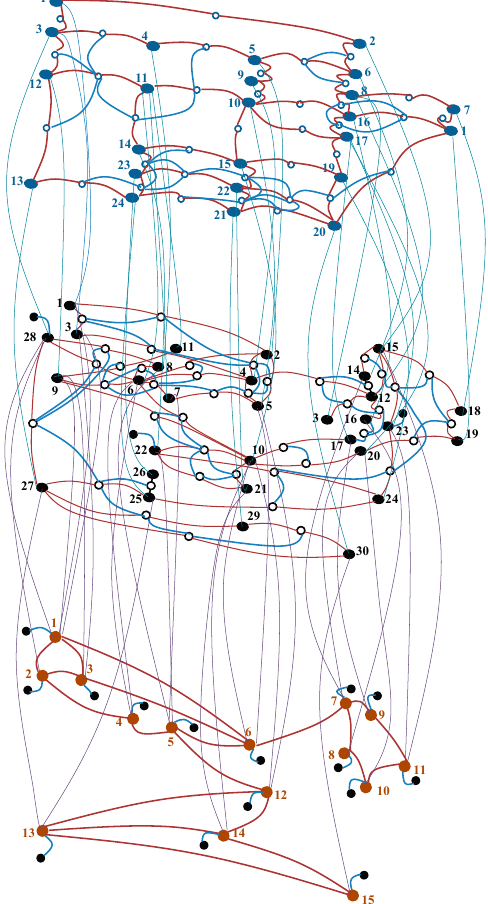
Figure 2. The operational interdependency influence graph 𝓖 ℐ = (𝕍 ℐ , 𝔼 ℐ ) .